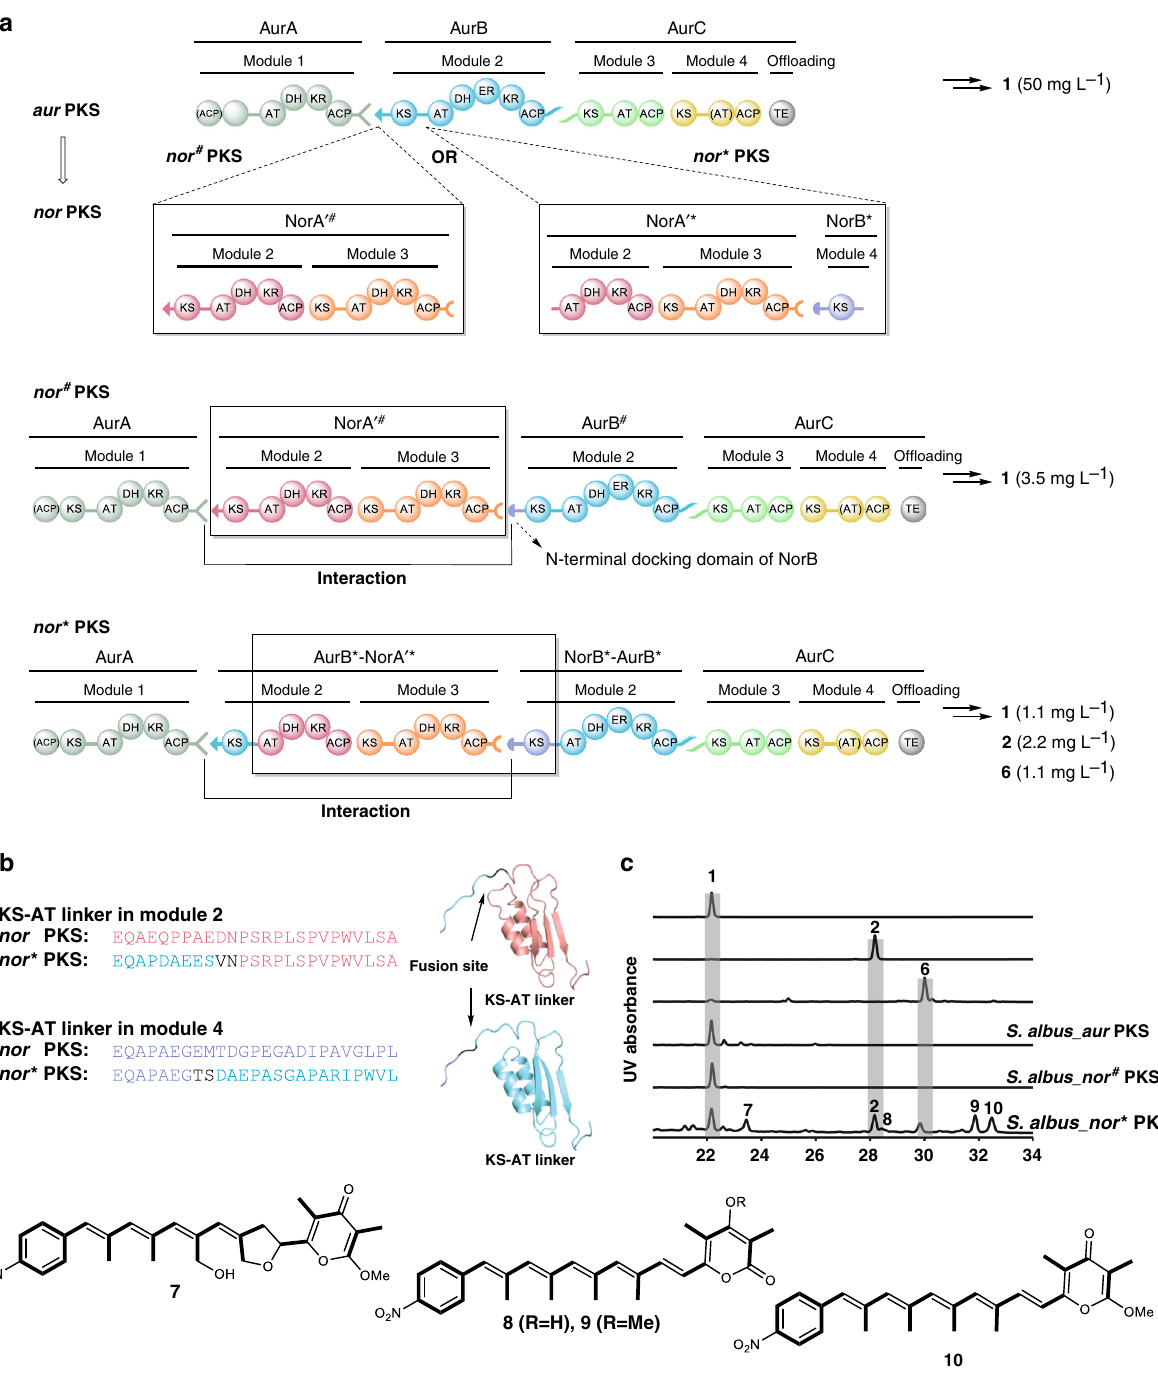
Fig. 5 Overview and metabolic pro fi le of modi fi ed aur PKS variants nor # PKS and nor* PKS. a Domain architectures of the nor # PKS and nor* PKS. The N- terminal docking domain of aurB is swapped to that of norB in the nor # PKS. In the nor* PKS, the length of recombinant KS-AT linker is manipulated to match that of the nor PKS. b The fusion sites are within the KS-AT linker and induced by the restriction enzyme Hpa I and Spe I. The amino acid sequences at the fusion regions of nor PKS and nor* PKS are aligned. c HPLC pro fi le of authentic standard of aureothin ( 1 ), neoaureothin ( 2 ), deoxyneoaureothin ( 6 ), and S. albus mutant strains. UV detection is at 350